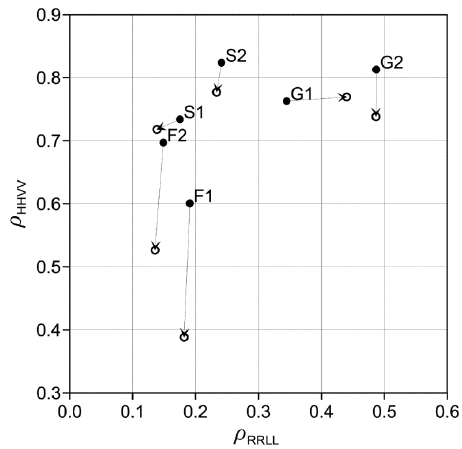
Figure 8. Change vectors of the test sites between frozen (closed circle) and thawed (open circle) conditions displayed in the ρ RRLL – ρ HHVV